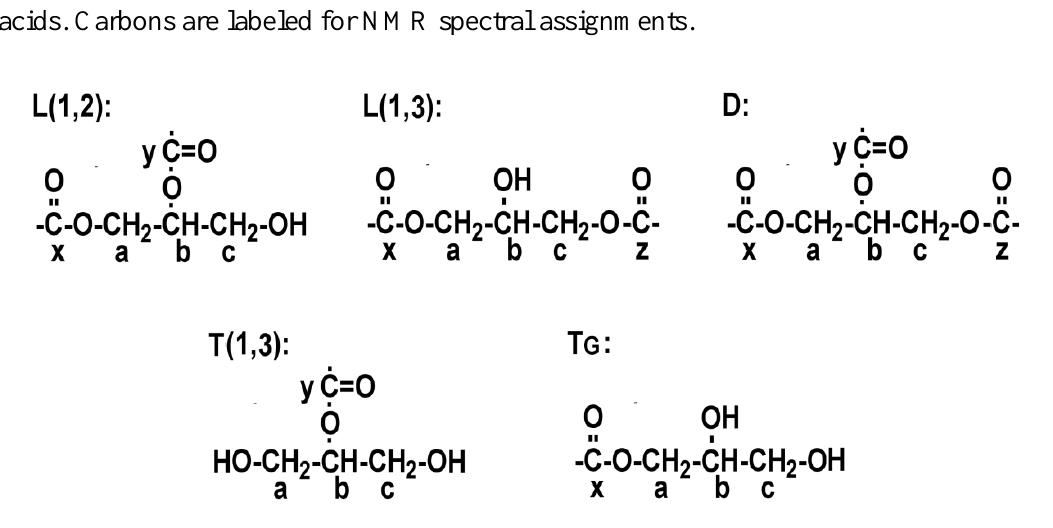
Figure 1. Subsititution patterns for the glycerol backbone after reaction with one or more diacids. Carbons are labeled for NMR spectral